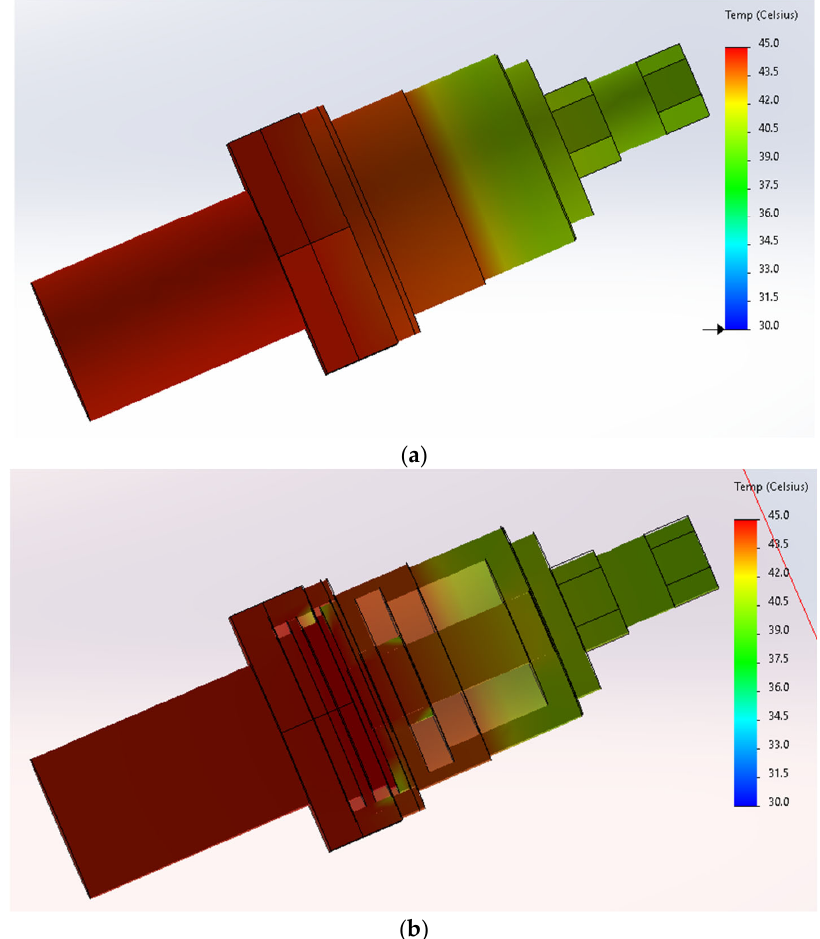
Figure 3. Temperature distribution on the case for P j = 5.48 W; ( a ) temperature distribution on the external surface of the case, ( b ) temperature distribution on the internal surfaces of the case.